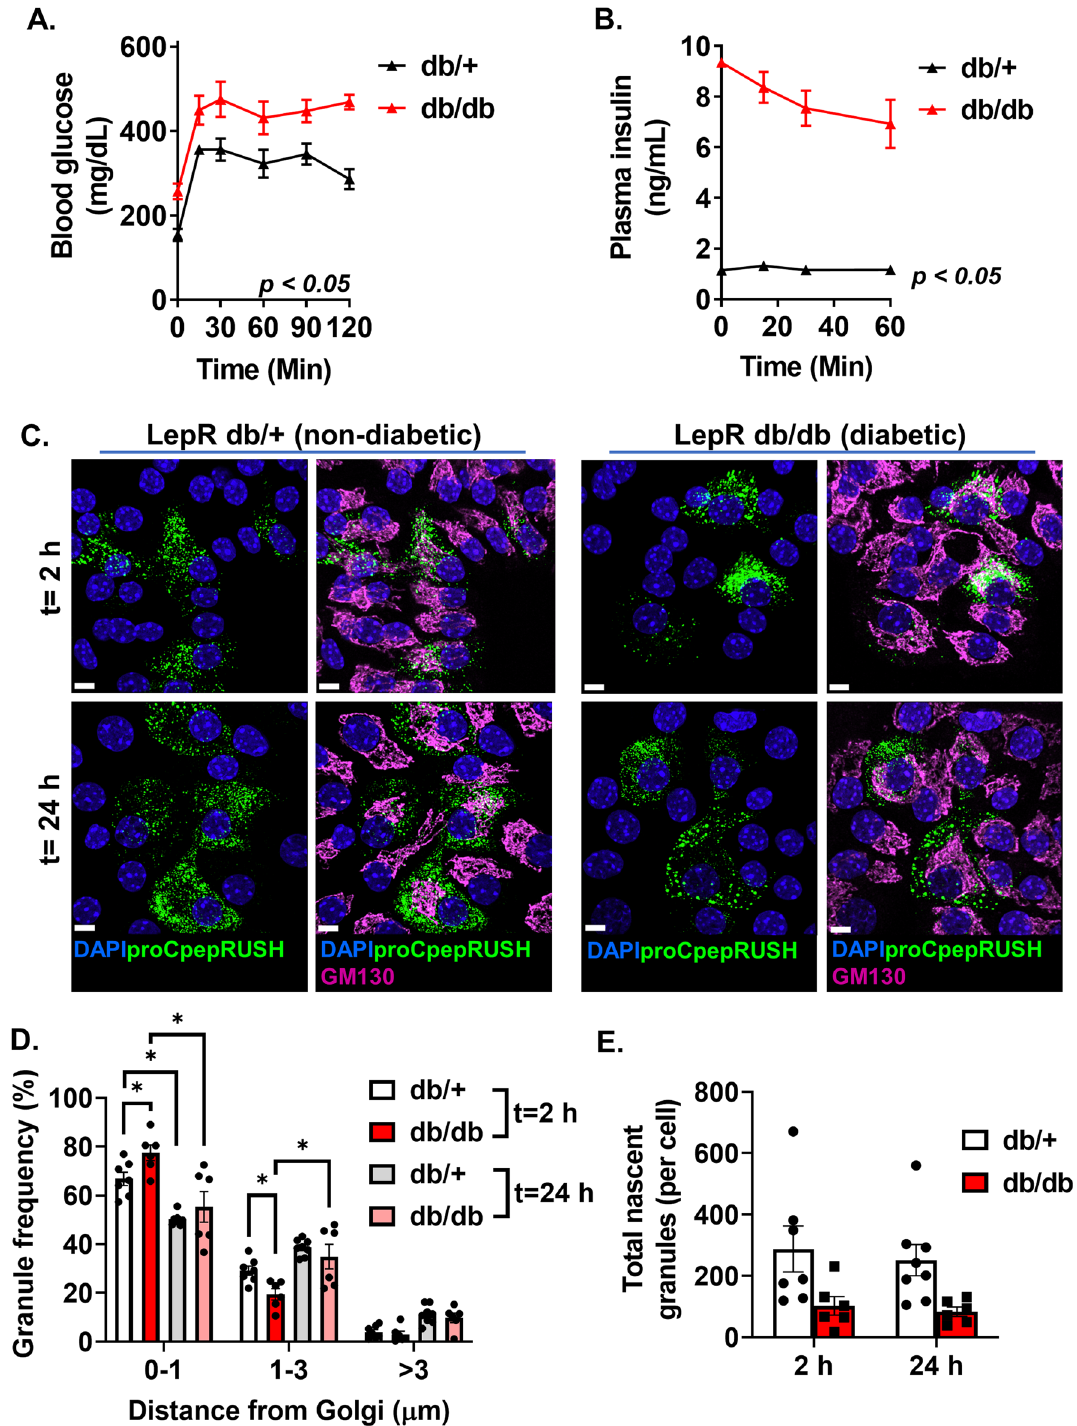
Figure 6. Impaired insulin trafficking from the Golgi in a genetic model of islet dysfunction. ( A – B ) 10–14 wk old C57BLKS/J db/ + or db/db mice (n = 4 mice per genotype) were fasted for 4 h and then injected i.p. with glucose (1 mg/g bw). Blood glucose was monitored for 2 h as indicated ( A ) and plasma sampled for insulin ( B ). ( C-E ) Isolated islets from 10 to 14 week C57BL6/J db/ + or db/db mice were treated with AdRIP-proCpepRUSH. 48 h post-infection, islets were incubated at 19 °C for 1 h and treated with biotin (200 μM) for an additional 2 h at 19 °C to initiate proCpepRUSH (green) trafficking, but block Golgi exit. Islets were then shifted to 37 °C for the indicated times to stimulate Golgi release. Cells were immunostained for GM130 (magenta) and counterstained with DAPI (blue). Islets were imaged by confocal microscopy. ( C ) Representative images are shown for Golgi release t = 2 h and 24 h. ( D ) The distances of proCpepRUSH-positive granules from the Golgi (2 h and 24 h post-Golgi release) were normalized as a frequency distribution per cell (n = 6–8 mice per group; 5–23 cells per mouse). ( E ) Total proCpepRUSH-positive granule numbers were quantified for each timepoint (n = 6–8 mice per group). ( A , B , D , E ) Data represents the mean ± S.E.M. * p < 0.05 by 2 way-ANOVA with Sidak post-test analysis. Scale bar = 5